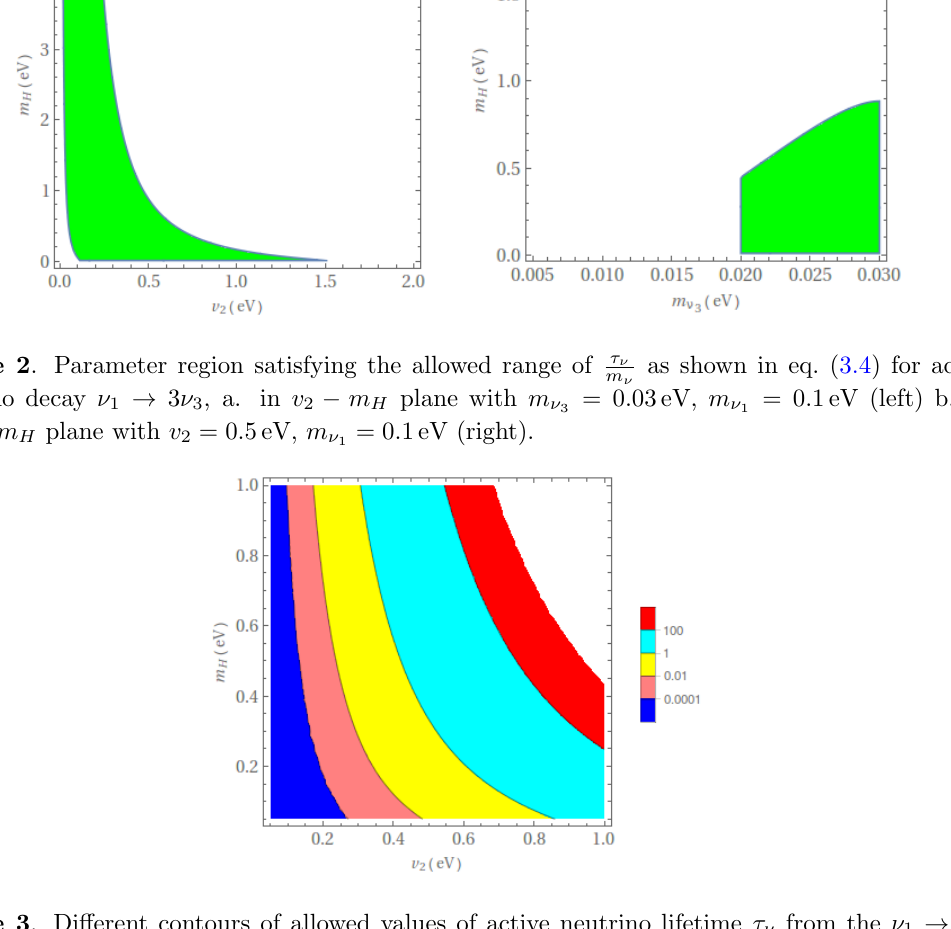
Figure 3 . Di(cid:11)erent contours of allowed values of active neutrino lifetime (cid:28) (cid:23) from the (cid:23) 1 ! 3 (cid:23) 3